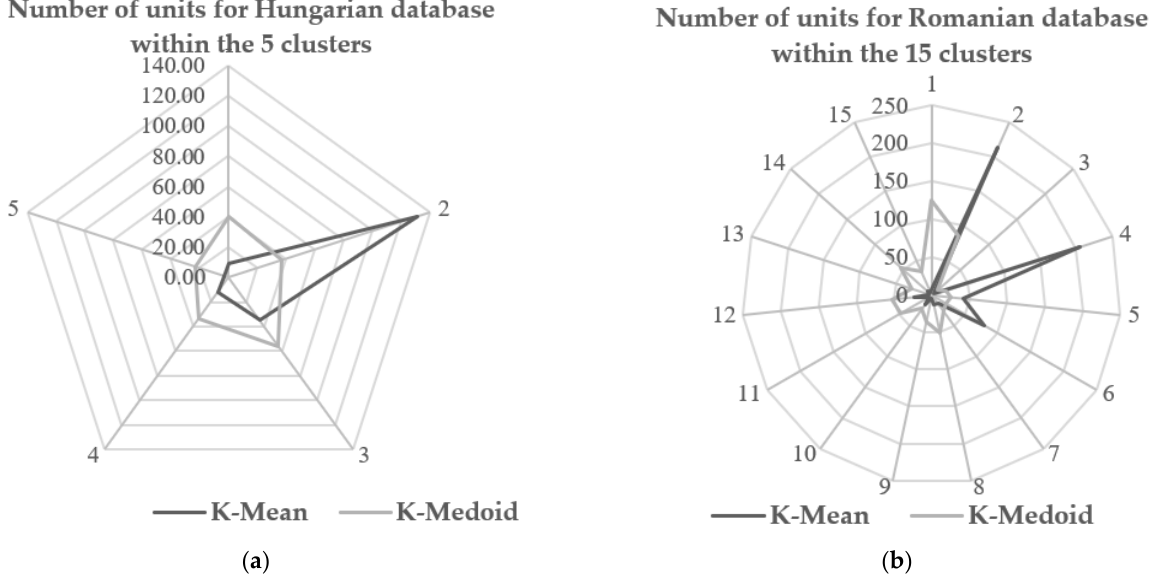
Figure 6. ( a ) Number of companies for Hungarian database within the clusters. ( b ) Number of companies for Romanian database within the clusters. Source: Authors ’ own editing, based on own for Romanian database within the clusters. Source: Authors’ own editing, based on own calculations.